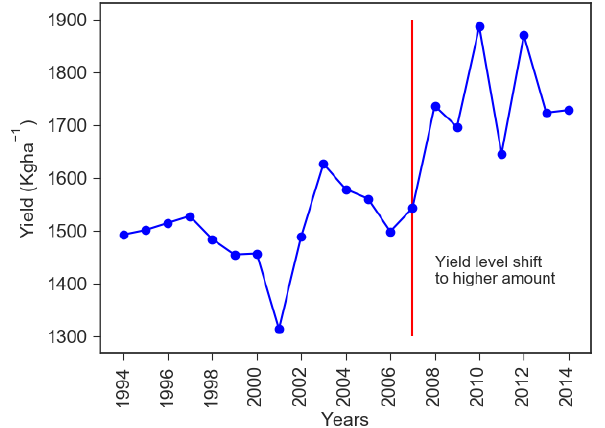
Figure 4. Maize yield in Ghana 1994–2014. There are two separate periods marked by the red lines during which we observe changes in yield. For 1994–2006 there is no clear trend in the yield pro- duced and for 2007–2014 there is a shift in the production in which a higher yield is observed.